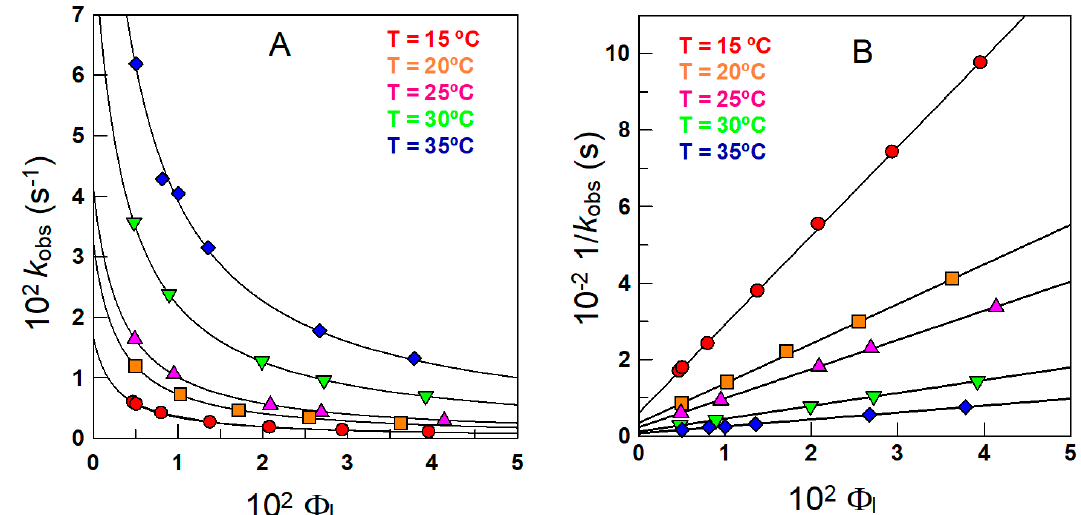
Figure 4. Illustrative variations of k obs ( A ) and 1/ k obs ( B ) vs. Φ I for caffeic acid (CA) at different temperatures. The solid lines are the theoretical curves obtained by fitting the experimental data to Equation (13) and to its reciprocals. Reprinted from ref. [66] with permission, copyright Royal Society of Chemistry.